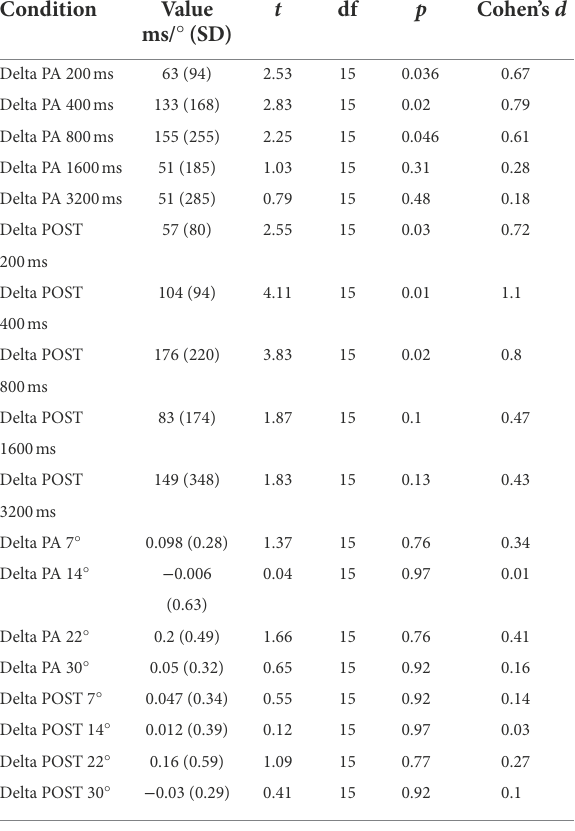
TABLE 1 Summary of t -tests against zero of % Deltas for both the temporal and spatial estimation task. Condition